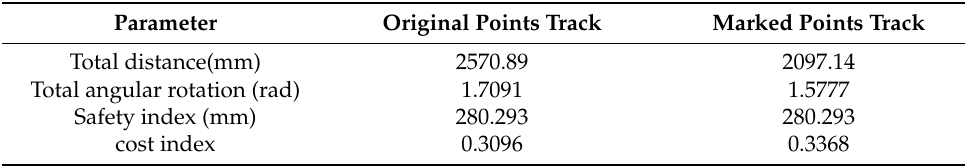
Table 5. Simulation parameters of the point-searching